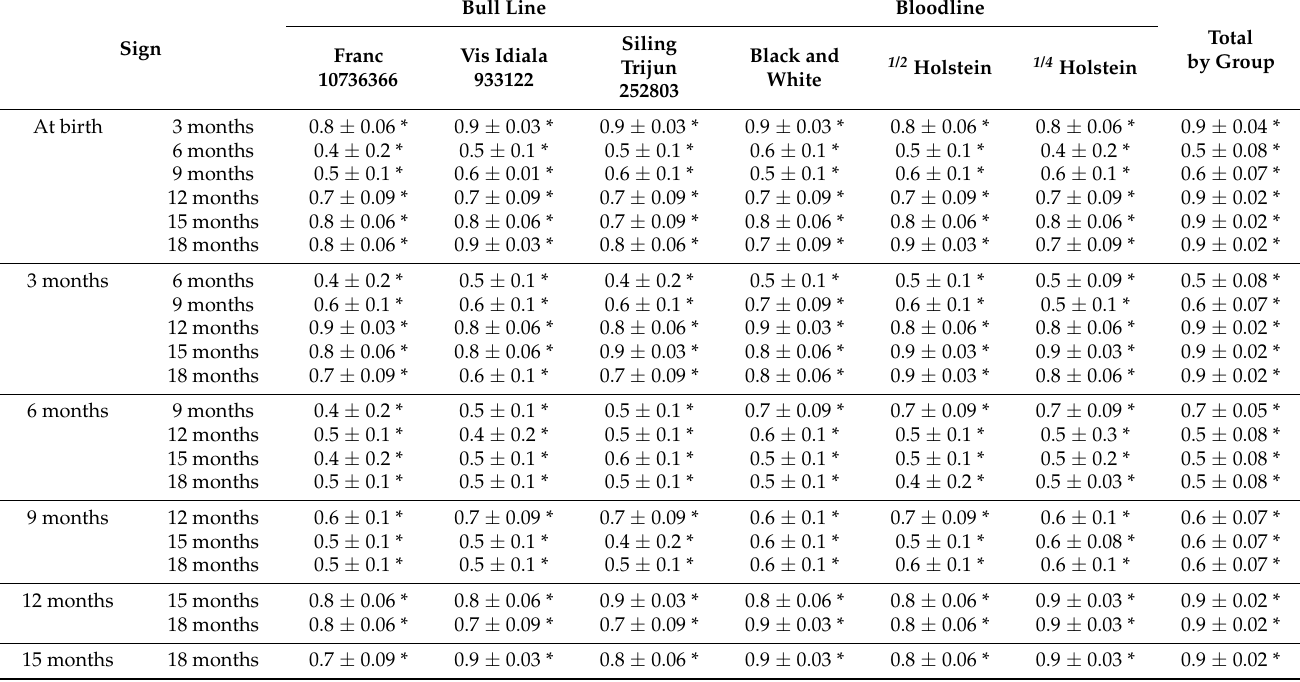
Table 1. Correlation coefficients between indices of live weight of bulls in different periods of